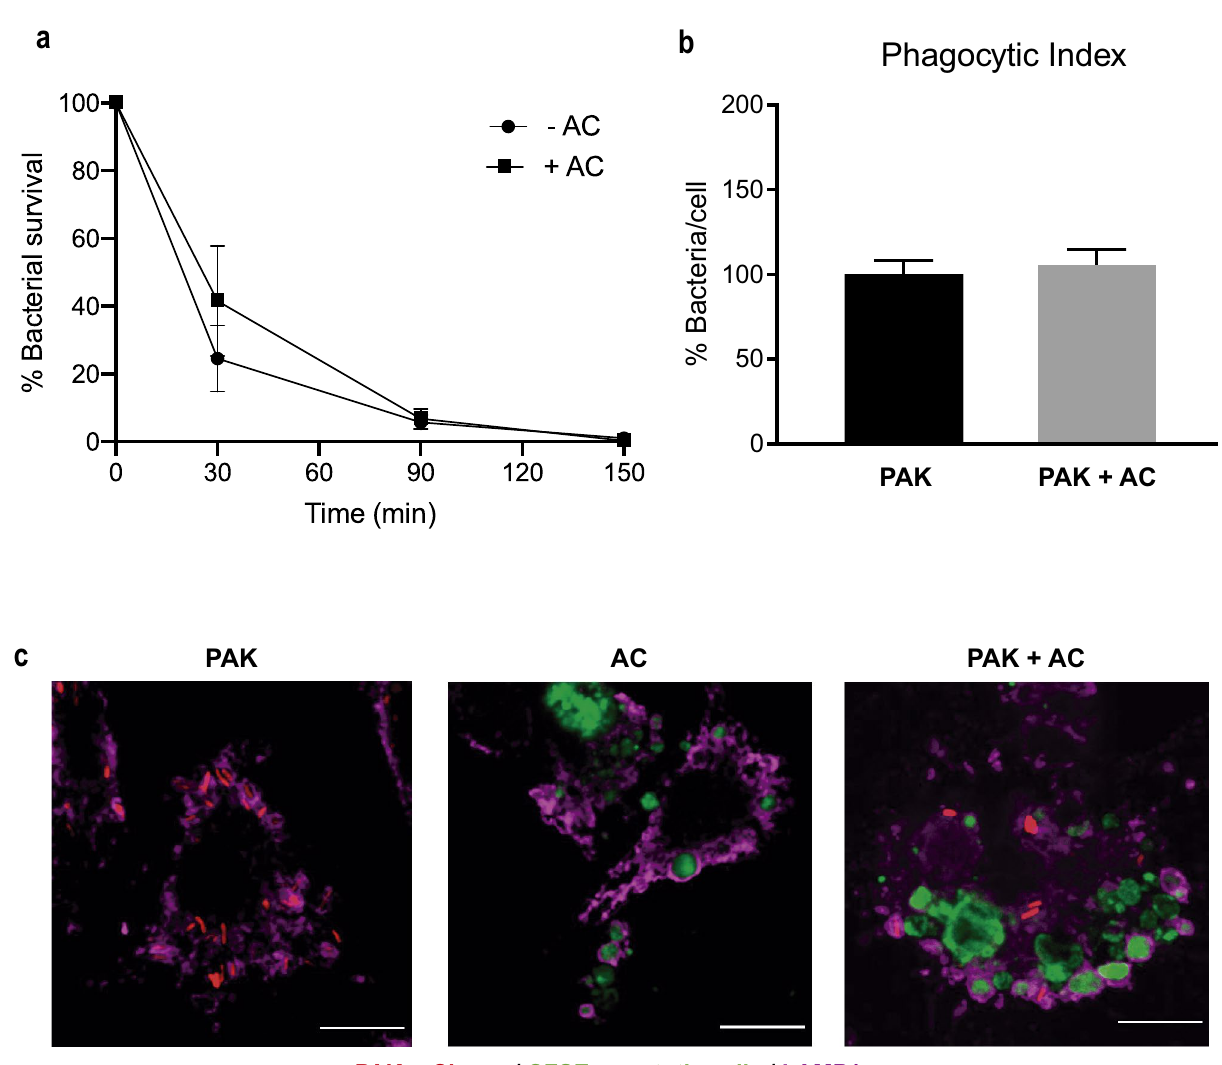
Figure 2. P. aeruginosa is eliminated by murine primary BMDM inside LAMP1-positive vesicles. ( a ) Intracellular bacterial survival over time was measured by standard antibiotic protection assays followed by CFU counting. Data presented as mean of CFUs ± SEM were normalized to time 0 (100%). This assay was done in the absence (−AC) or presence of apoptotic cells (+AC). Three independent experiments were performed. No significant differences were found by unpaired t test. ( b ) Phagocytic Index. Cells were incubated with the targets for 30 min. The index was calculated as the average number of bacteria internalized per cell in the presence or absence of apoptotic cells. Data were calculated as mean ± SEM and normalized to the condition with only bacteria (100%). PAK bacteria alone, PAK + AC PAK with apoptotic cells concurrently. Three independent experiments were performed. No significant differences were found by unpaired t test. ( c ) P. aeruginosa and apoptotic cells localize to LAMP1-positive vesicles. BMDM were fed for 50 min with PAK-mCherry, CFSE- labeled apoptotic cells, or both concurrently. Confocal projected Z-stacks showing LAMP1-positive vesicles containing bacteria and apoptotic material. Scale bars 10 µm. Green: CFSE-labeled apoptotic cells. Red: PAK- mCherry. Magenta: